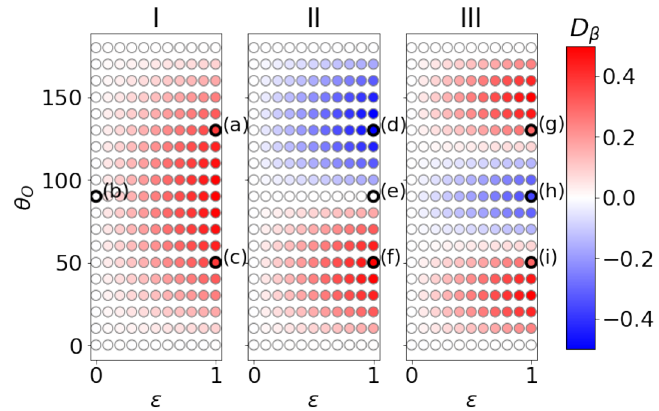
Figure 8 . Vertical shifts D β (indicated by the color bar) of the center of the shadow images for the three types of soft hair functions given in (4.8)–(4.10) with the size parameter E tuned between 0 and 1 , and for different observer’s inclination angles. The shadow morphology for the parameters indicated by (a)-(i) are shown in figure